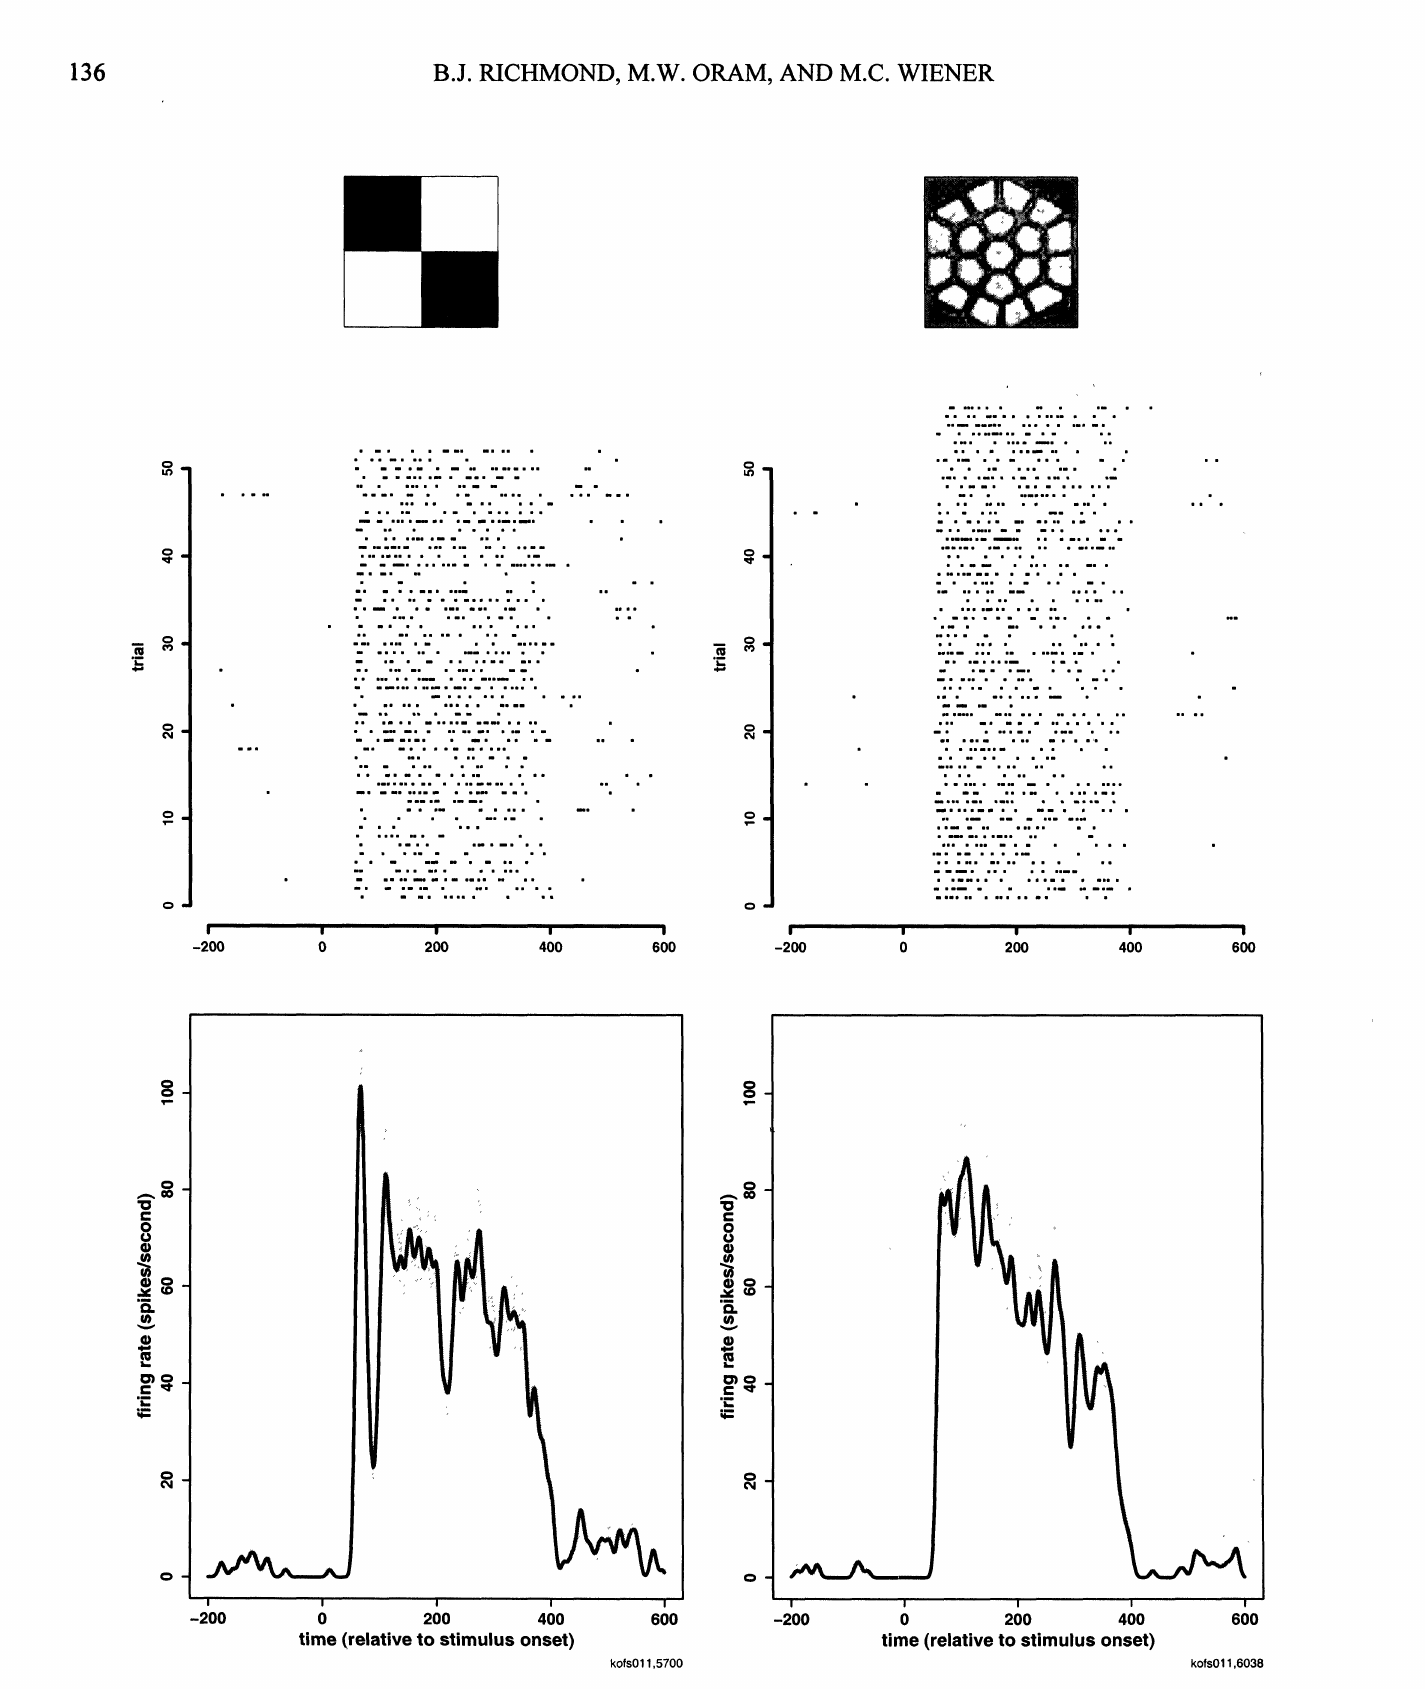
Fig. 2: Responses elicited by two stimuli from a V supragranular complex cell that are equal in response strength and different in temporal pattern. Two temporal features can be used to differentiate these responses. The first is the presence of the -25 ms gap in the early response on the left and not on the right. The second is the progressively decreasing strength seen prominently in the response on the